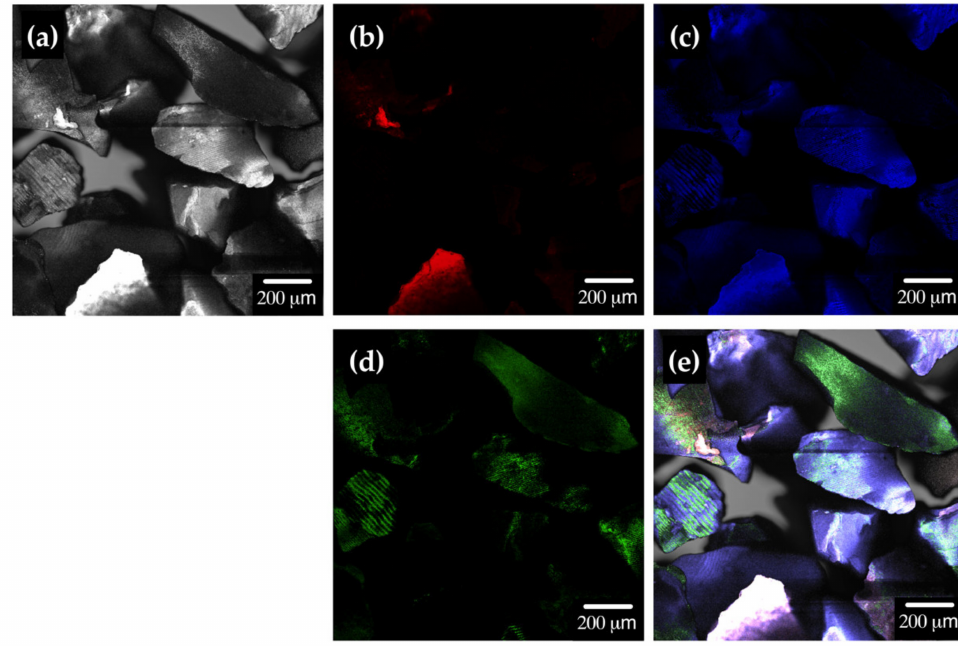
Figure 9. ( a ) Optical and ( b – d ) confocal micrographs of the Ni 2+ -loaded CS at ( b ) 519 nm, ( c ) 461 nm, and ( d ) 636 nm. ( e ) Overlay of all four images for the Ni 2+ -loaded